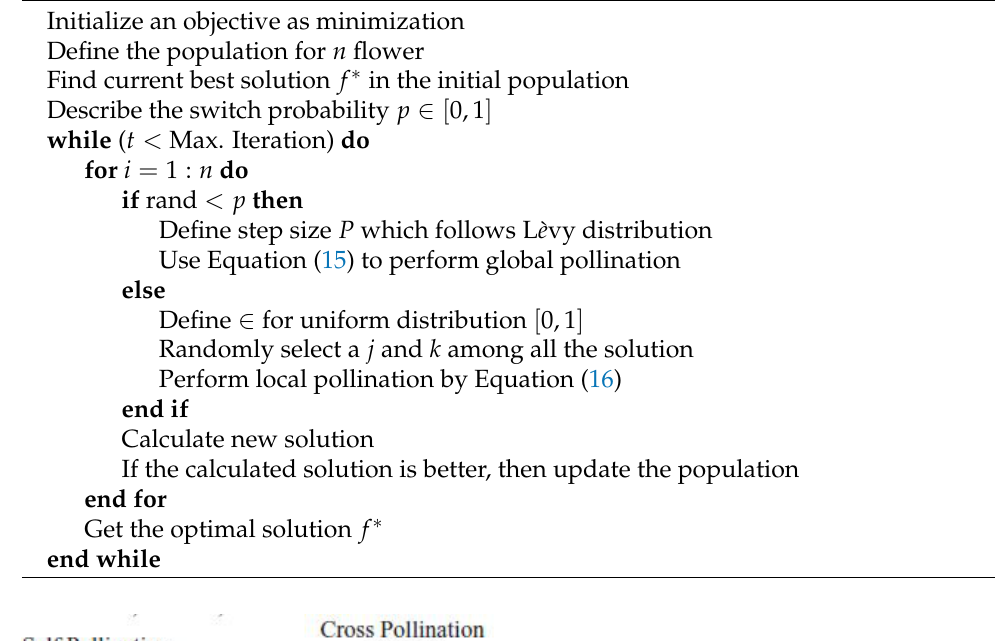
Algorithm 2 Pseudo code for FP Algorithm [73,74]